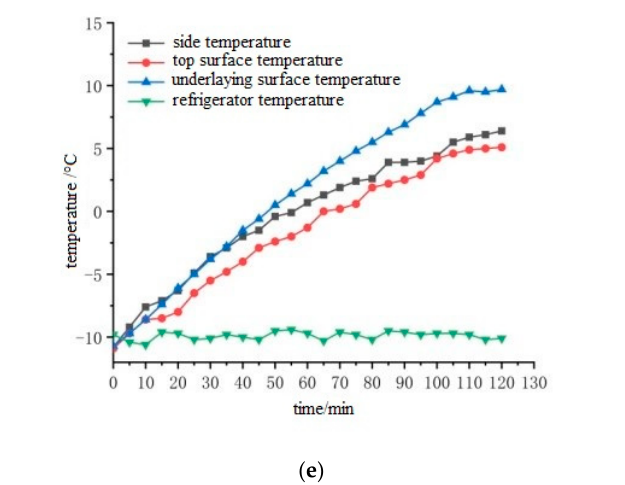
Figure 5. Heating diagram of different electrodes. ( a ) Heating of 0.1 mm thick externally bonded aluminum sheet; ( b ) Heating of 0.1 mm thick externally bonded zinc sheet; ( c ) Heating of 0.1 mm thick externally bonded copper sheet; ( d ) Heating of 0.1 mm thick externally bonded iron sheet; ( e ) Heating of 0.1 mm thick externally bonded stainless steel sheet.